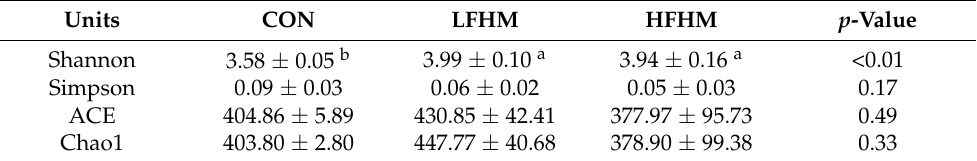
Table 7. Effects of different amounts of fermented Chinese herbal medicine on microorganisms in the gut of weaned piglets alpha diversity impact (%).